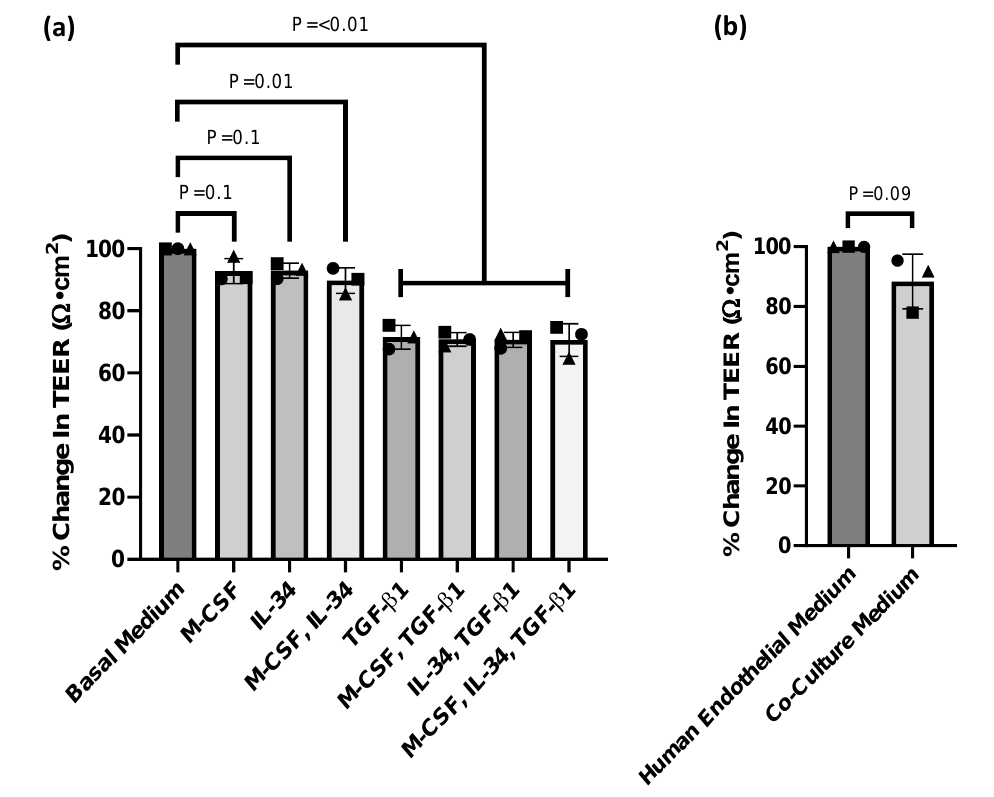
Figure 2. Recombinant human transforming growth factor-beta 1 (rhTGF- β 1) strongly diminishes hiPSC-derived BMEC barrier prop- erties. ( a ) On day 13 of the differentiation process, basal medium supplemented with ±100 ng/mL recombinant human interleukin- 34 (rhIL-34), ±25 ng/mL recombinant human macrophage-colony stimulating factor (rhM-CSF) and ±50 ng/mL rhTGF- β1 was added to the BMECs with the TEER measured 24 h later. The percentage change in trans-endothelial electrical resistance (TEER) was nor- malised to the basal medium experimental condition (One-way ANOVA with Dunnett ’ s multiple comparisons test, p values dis- played on the graph, n = 3). ( b ) On day 13, the medium on the hiPSC-derived BMECs was replaced with either human endothelial medium or co-culture medium (Table S5), and the TEER was measured 24 h later. The percentage change in TEER was normalised to the human endothelial medium experimental condition (two-tailed unpaired t -test, p values displayed on the graph, n = 3). Each graphical symbol shape (square, triangle and circle) represents each set of experimental replicates. Having established that barrier integrity of hiPSC-derived BMECs remains largely intact in the presence of the co-culture medium, we next established a co-culture of the two hiPSC-derived cell types in the same well of a culture plate: hiPSC-derived microglia were cultured adherently at the bottom of the basolateral compartment while hiPSC-de- rived BMEC were kept on the apical side of a membrane separating the two compart- ments. Both cell types were combined in the same well on day 13 of differentiation (Figure 1a).